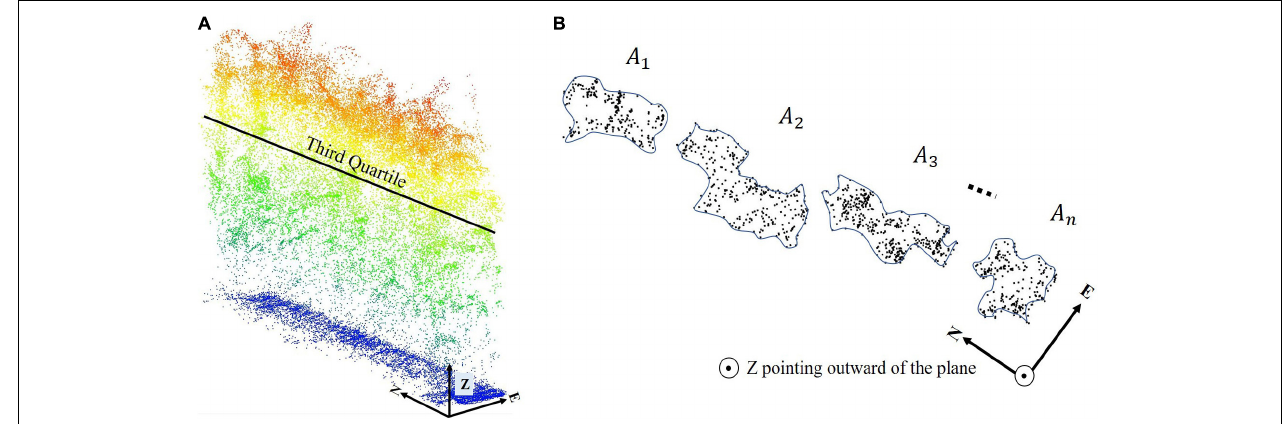
FIGURE 10 | Sensitivity analysis: Feature correlation matrix (zero is the lowest correlation and 1 is the highest correlation).